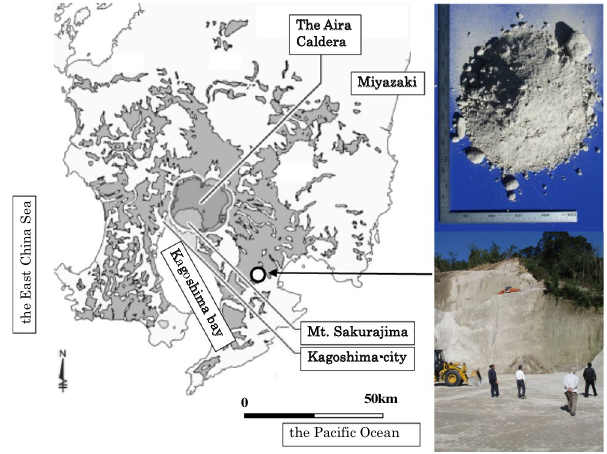
Fig. 3 Distribution of shirasu and location of sampling